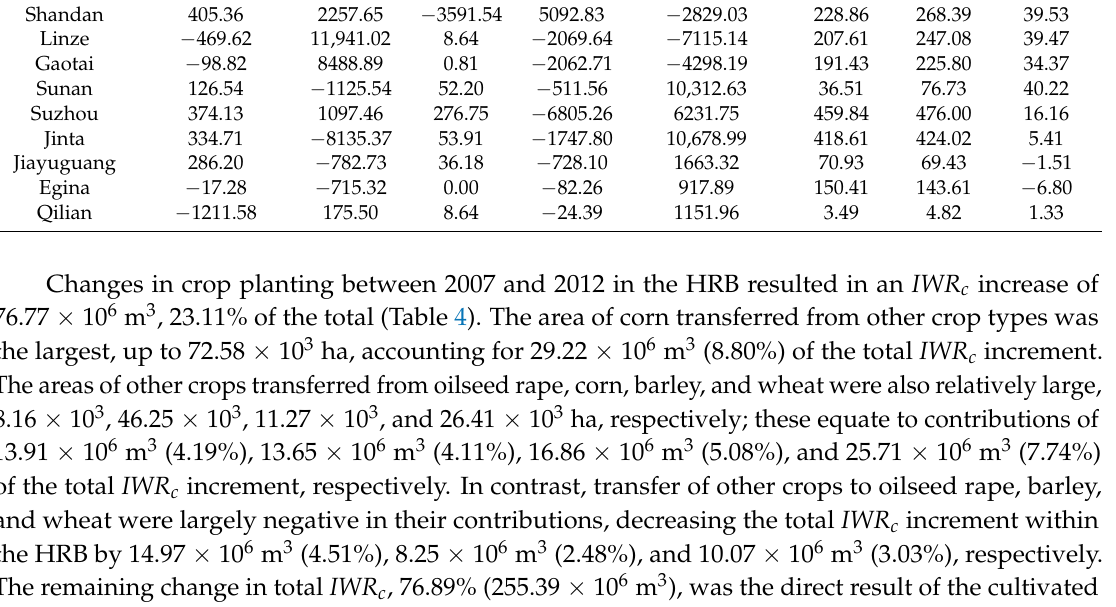
Table 3. HRB county-level changes in crop planting area and IWR c values between 2007 and 2012. Changes in Crop Planting Area (ha) Changes of Total IWR c (10 6 m 3 ) County Oilseed Rape Corn Barley Wheat Other Crops 2007 2012 Change Ganzhou − 1157.58 12,180.06 1418.31 5086.26